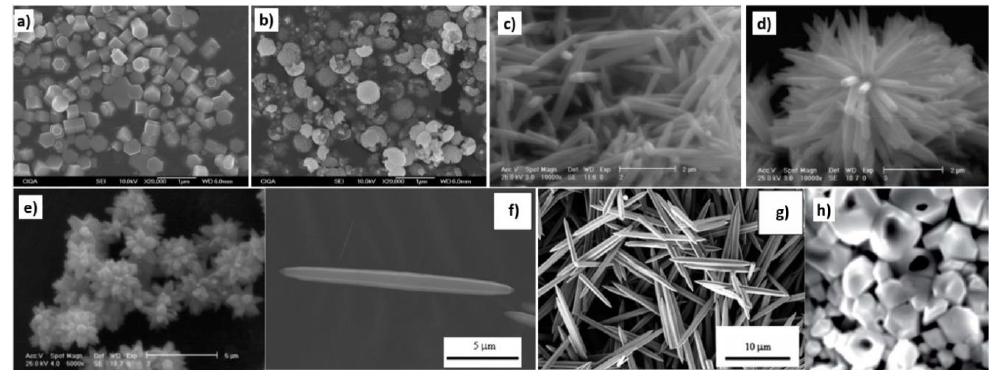
Figure 18. Examples of various ZnO structures obtained by the microwave hydrothermal synthesis: